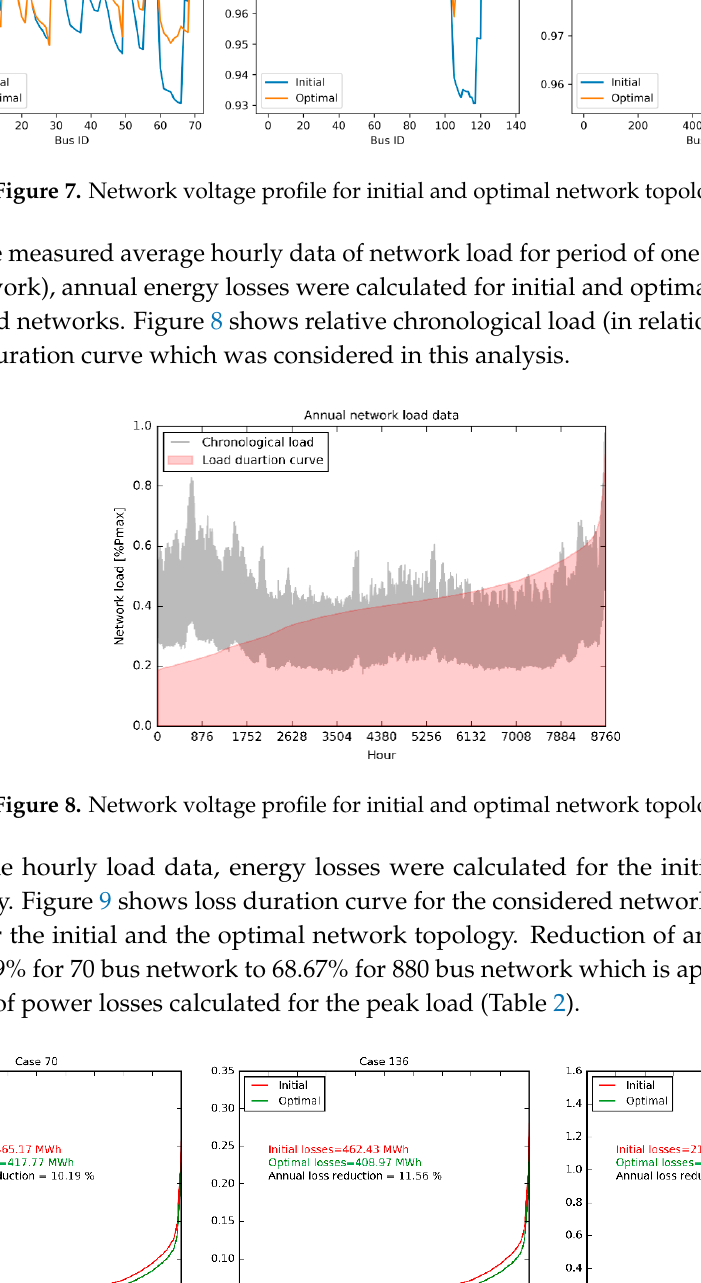
Figure 9. Network voltage profile for initial and optimal network topology.